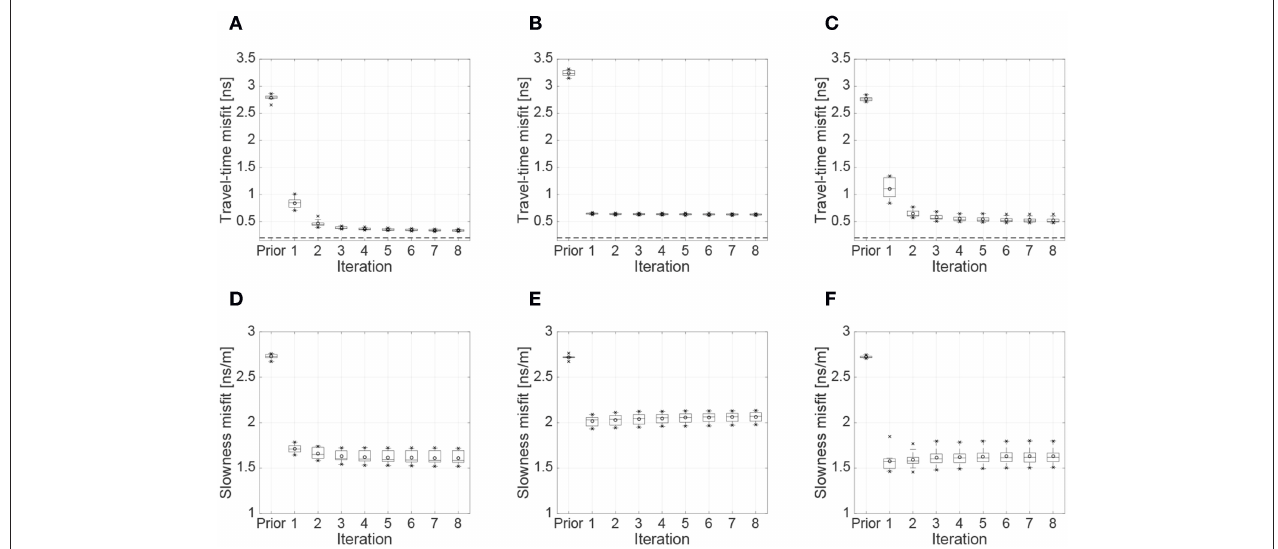
FIGURE 7 | Box plots showing the results of 10 ES-MDA runs using 160 ensemble members, as a function of the number of assimilation iterations, for the cases of (A,D) no model error; (B,E) model error present but not accounted for; and (C,F) model error present and accounted for using Algorithm 2 with 40 detailed solver calculations and 40 KNN. Added to the box plots are the mean (circles), and minimum and maximum values (crosses). The dashed horizontal line in (A–C) represents the expected value of the travel-time misfit assuming that the residuals follow the prescribed Gaussian distribution for the data